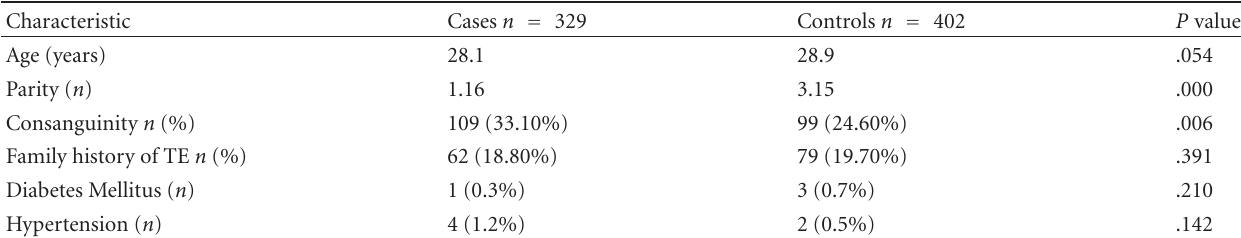
Table 1: Selected characteristics of cases and controls.